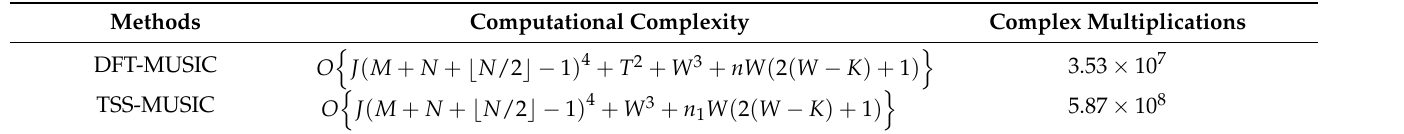
Table 6. Computational complexity comparison of different